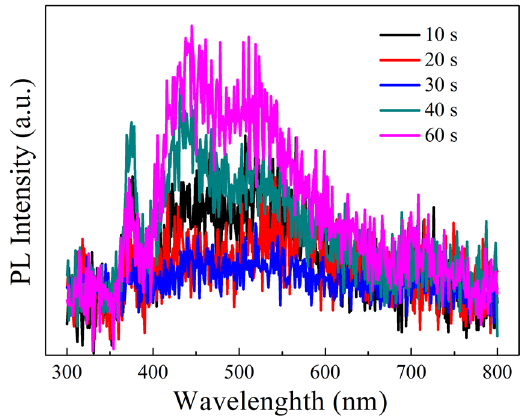
Figure 6. PL spectra of TiO 2